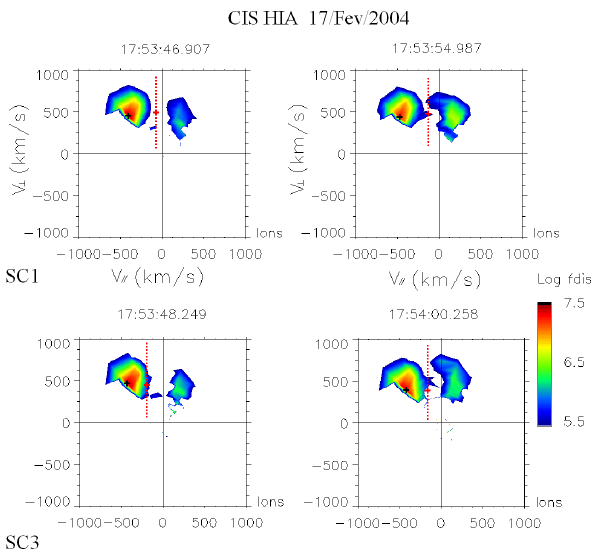
Fig. 6. 17 February 2004. Bi-dimensional cut-off of the ion distri- bution function in the Vper-Vpar plane for spacecraft 1 (top pan- els) and spacecraft 3 (bottom panel) from HIA instrument. The red cross represent the velocity of the deHoffmann-Teller frame and the black cross the velocity of the main ion population. Note that the ion distribution function of the transmitted ion population is trun- cated because of the operating mode of the HIA